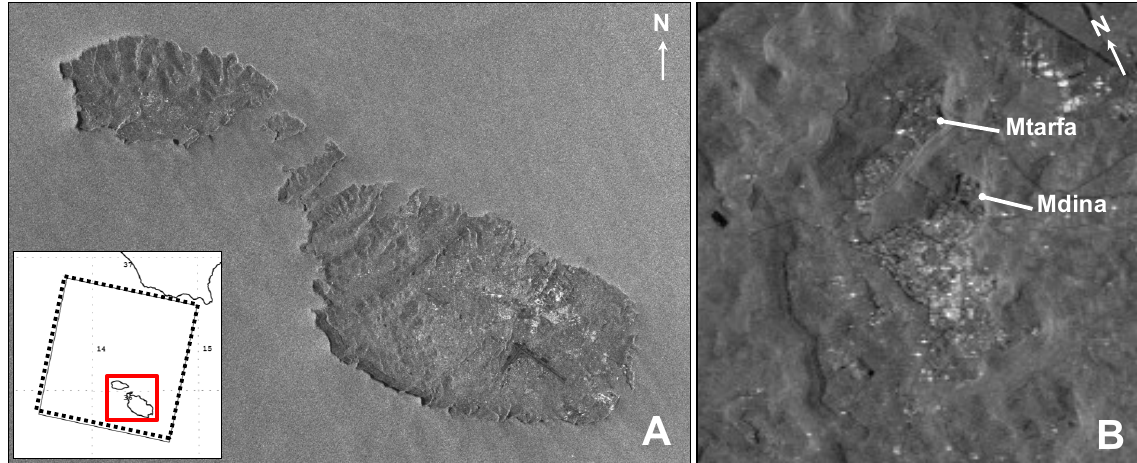
Fig. 9. Laser scanner in action at Vilhena Palace, Mdina (A) ; True coloured 3-D point cloud of Vilhena Palace, Mdina (B) .